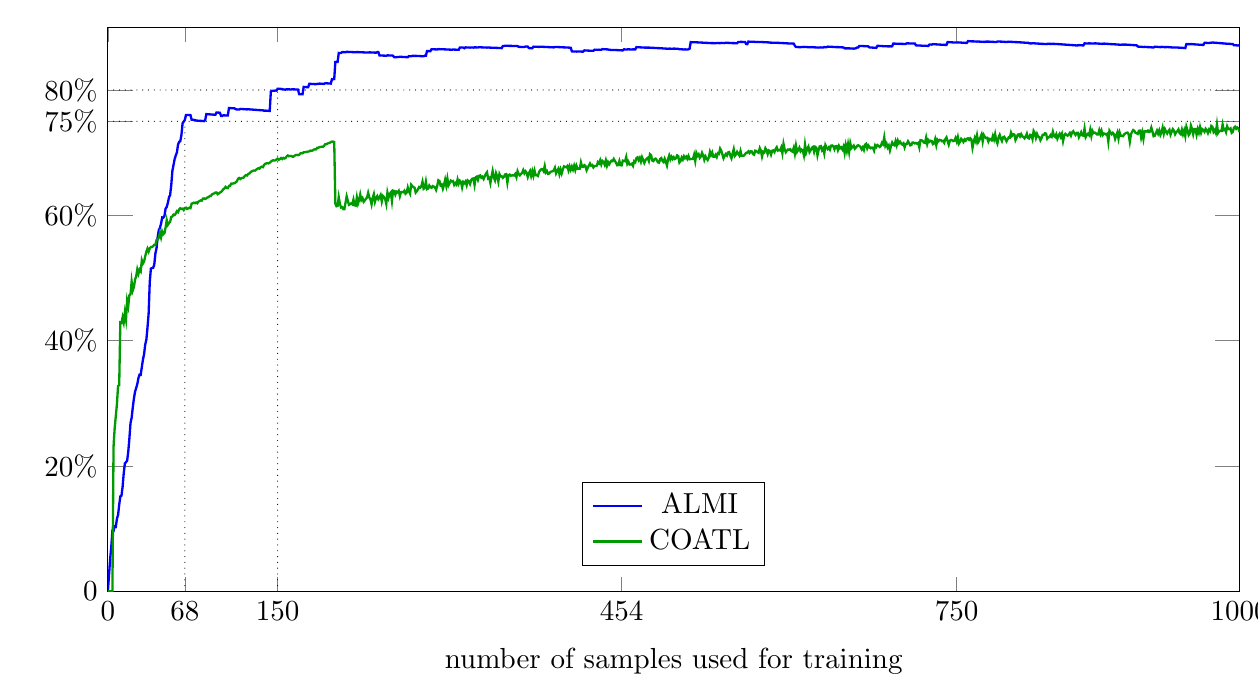
Figure 5. The accuracy values according to Equation (13) for ALMI (blue) and COATL (green) achieved on the Hausgarten dataset. The vertical straight lines show how many labels are required to achieve a performance of 75% resp.